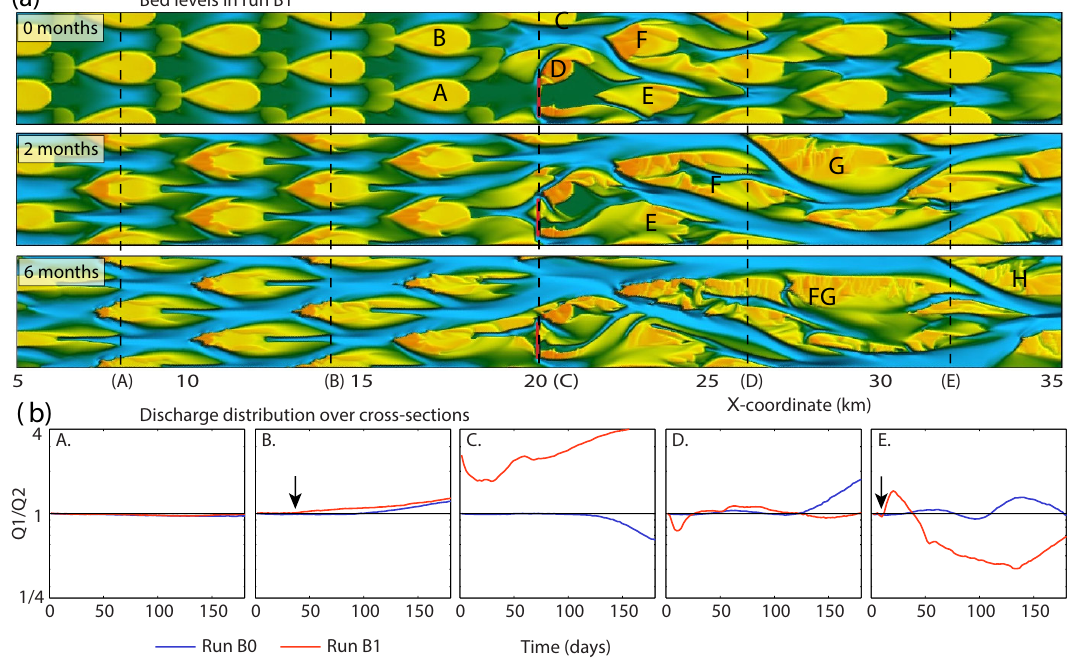
Figure 7. Evolution of the braided channel network and bar pattern in Run B1 with branch closure by a dam at x = 20km: (a) time series of the bed level and (b) discharge distribution with Q 1 the discharge through the northern branches. The black arrows indicate the position of the propagating